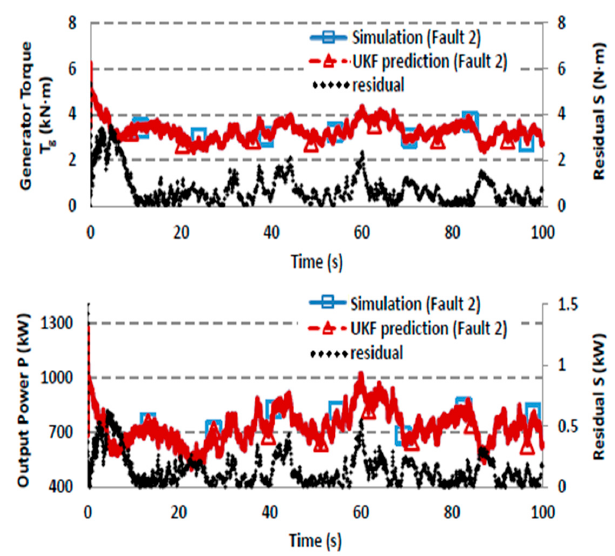
Figure 6. Comparison results of simulation and UKF prediction for a WT in Fault 2.